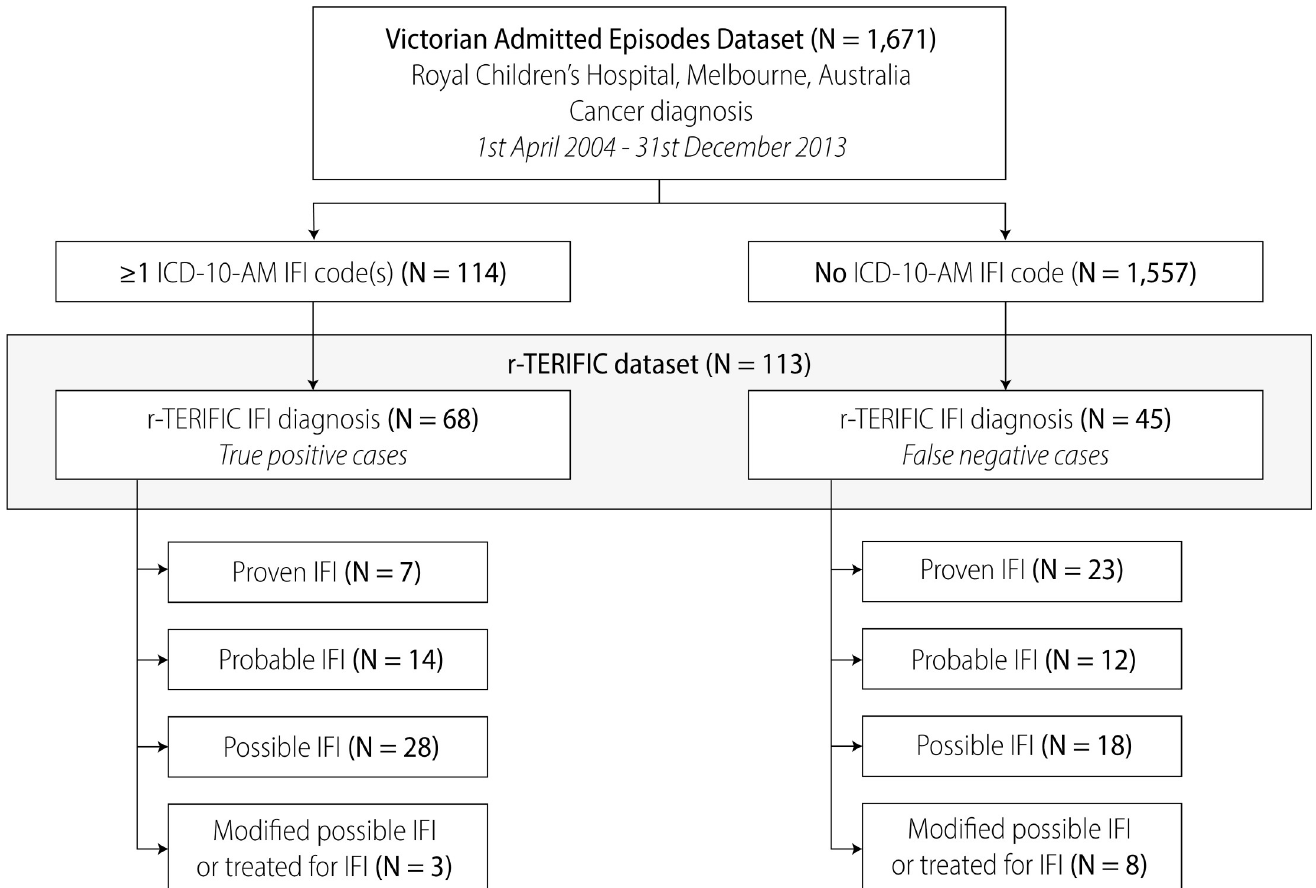
Fig 1. Consort diagram of the study methodology and the number ( N ) of linked patient records across the r-TERIFIC and administrative coding datasets. ICD-10-AM, International Statistical Classification of Diseases and Related Health Problems , Tenth Revision , Australian Modification ; IFI, invasive fungal infection; r- TERIFIC, The Epidemiology and Risk Factors for Invasive Fungal Infections in Immunocompromised Children (Royal Children’s Hospital); VAED, Victorian Admitted Episodes Dataset.